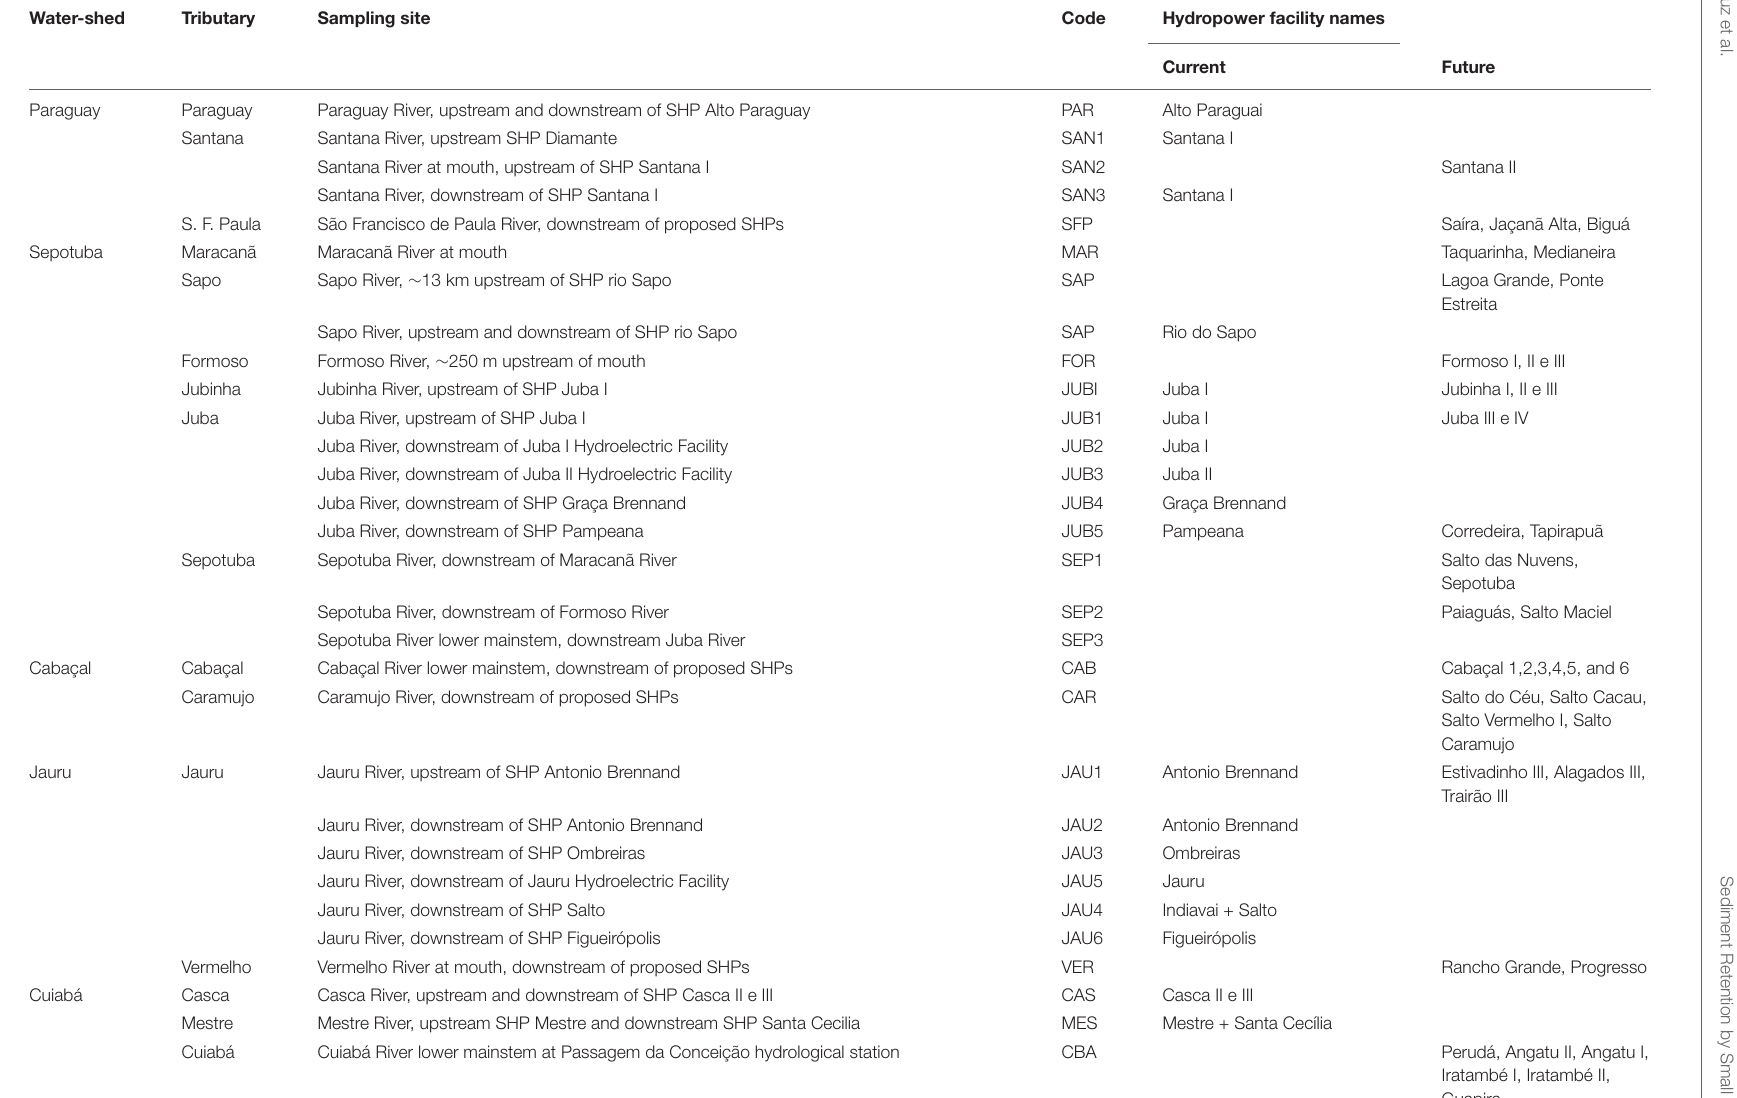
TABLE 1 | List of sampling sites and hydropower facilities they pertain to, with codes for figures and tables.